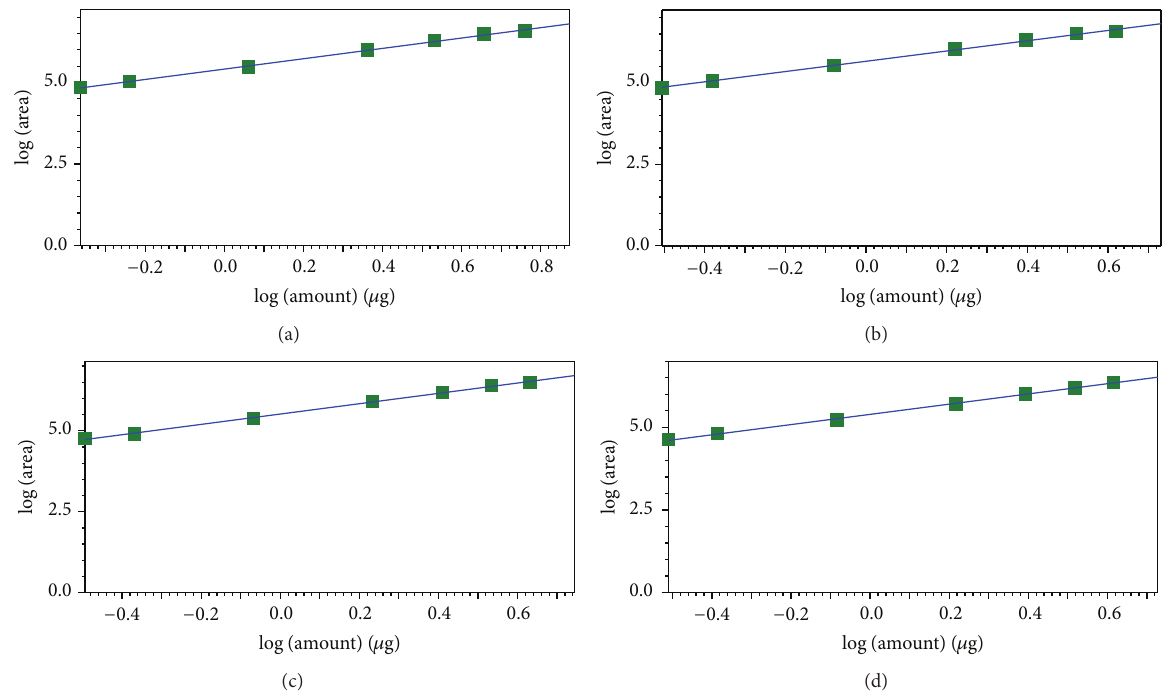
Figure 2: The calibration curves for the four analytes in the present study. (a) 3,4-Dihydroxyphenylethyl alcohol glycoside; (b) salidroside; (c) chlorogenic acid; (d);